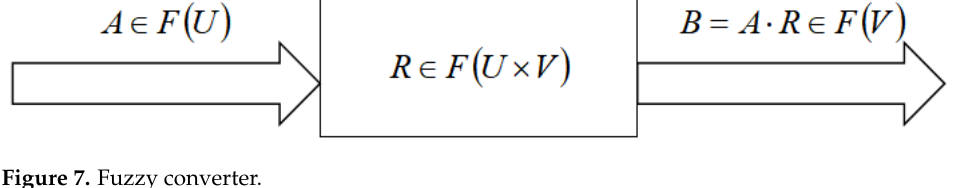
Figure 7. Fuzzy converter.